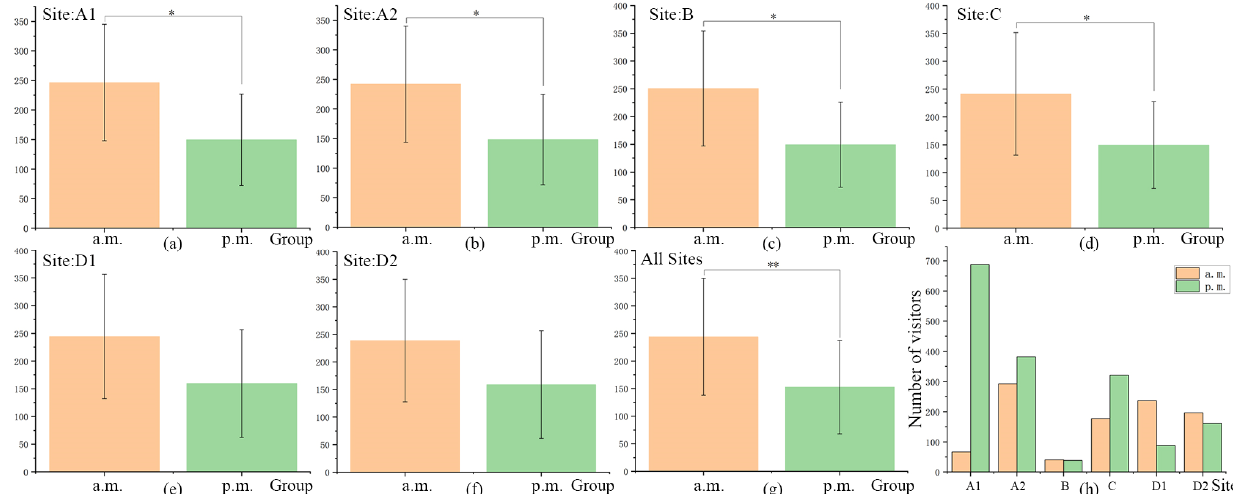
Figure 6. Variance analysis of temporal distribution of PM2.5 concentration and Spatial-Temporal Distribution of Visitor Activities. ( a – g ) Variance analysis of temporal distribution of PM2.5 concentration for each site ( h ) Spatial-Temporal Distribution of Visitor Activities. * p < 0.05, ** p < 0.01.